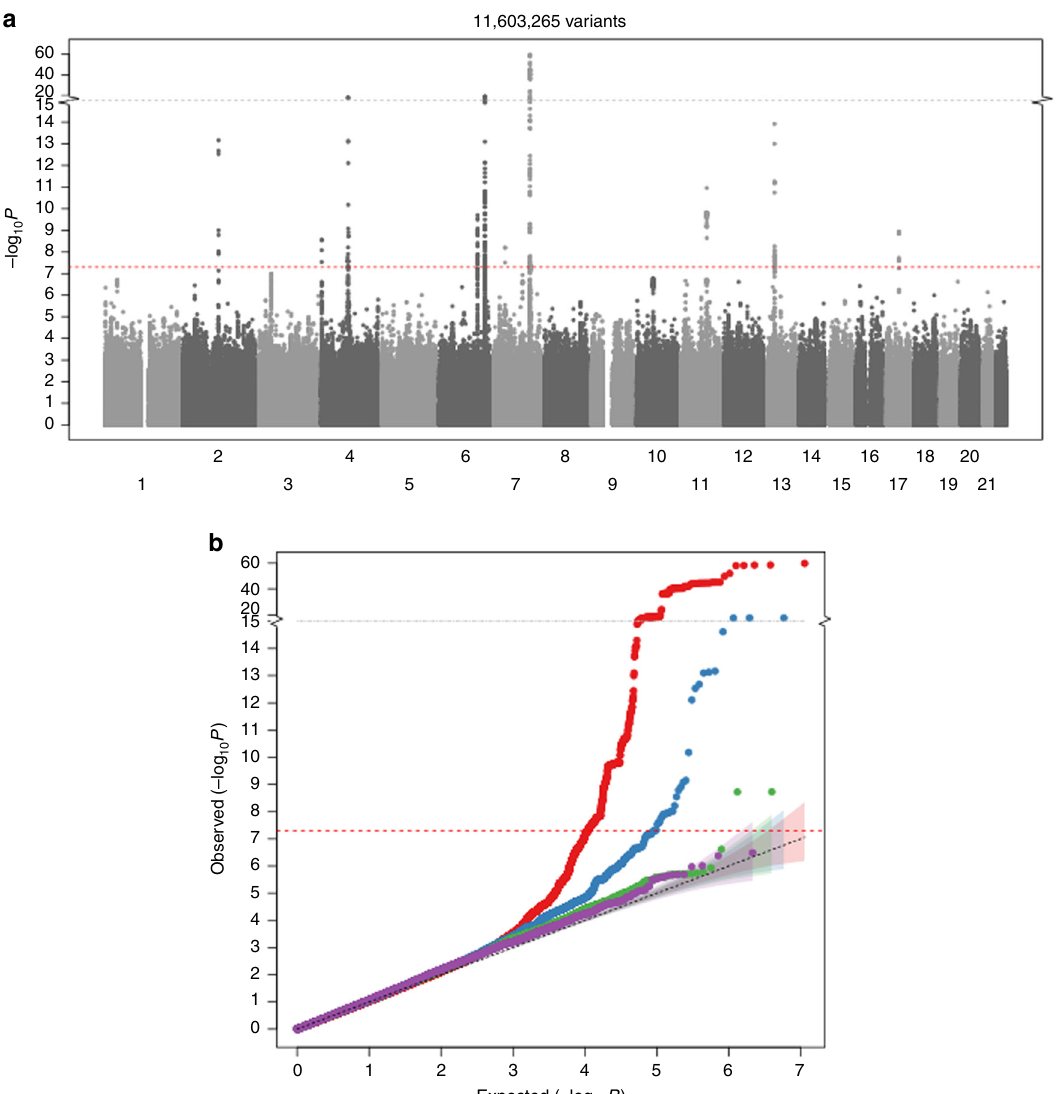
Fig. 1 Ultradistal forearm BMD Genome-wide association analysis results. Manhattan (upper panel) and QQ-plot (lower panel) in HUNT dataset ( N = 19,705) for ultradistal forearm bone mineral density (BMD) genome-wide association analysis. In the Manhattan plot (upper panel) the genome-wide signi fi cance threshold ( P -value < 5 × 10 − 8 ) is shown using a red dotted line. In the QQ-plot (lower panel), the tested variants have been divided into four groups based on MAF (red dots = MAF [0.05; 0.5], blue dots = MAF [0.005; 0.05], green dots = MAF [0.001; 0.005], purple dots = MAF [0.000253; 0.001]). MAF: minor allele frequency. − log 10 P: − 1 × tenth logarithm of the association test P